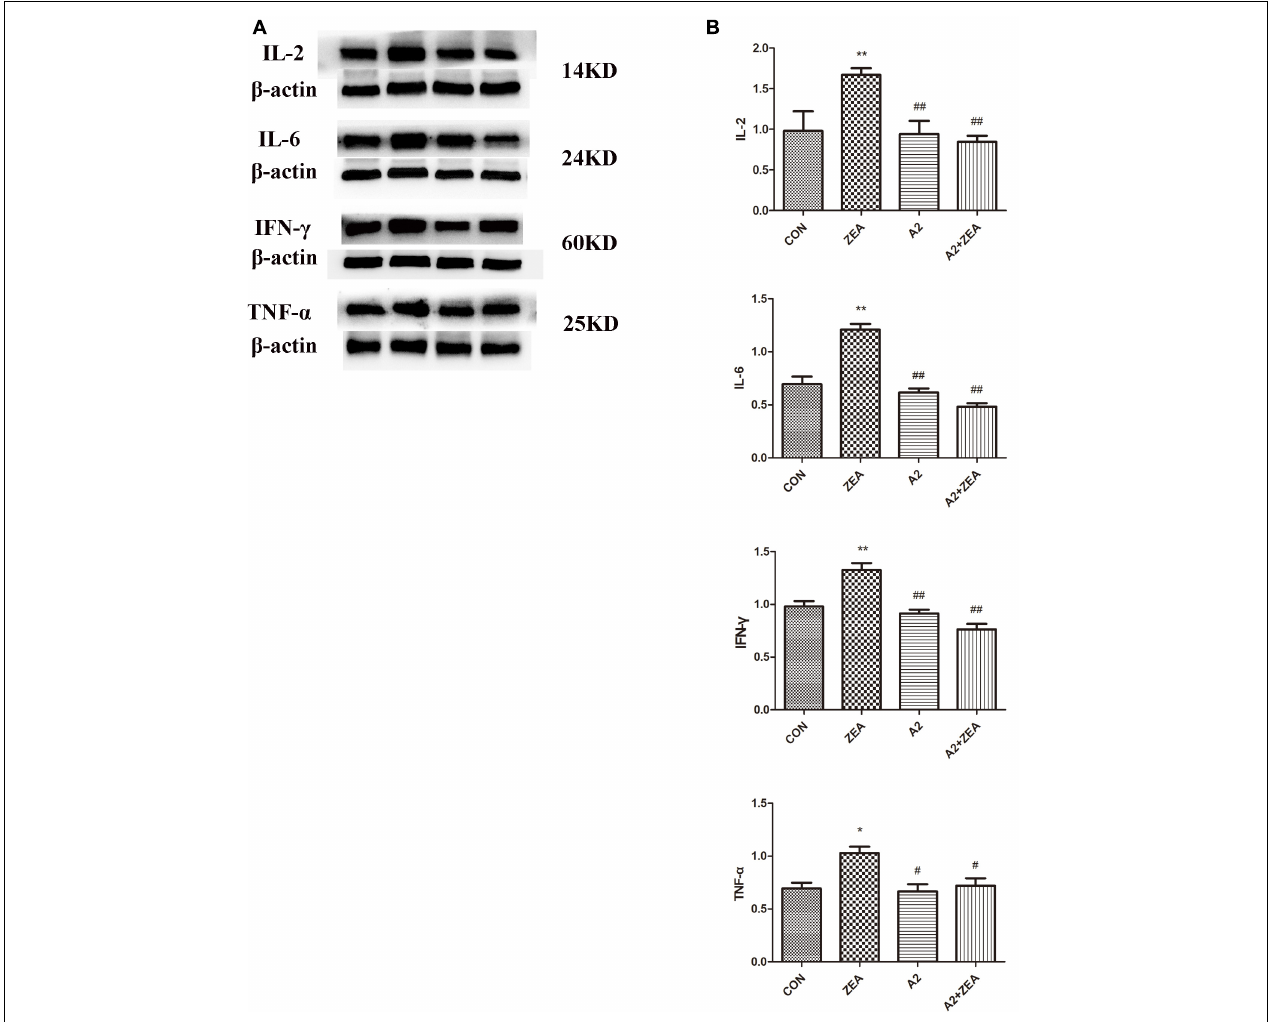
FIGURE 5 | (A) Protein expression of cecal inflammation indicators in each group. (B) The data in the figure were all from at least three independently repeated trials. “*” means a significant difference compared with the CON group ( P < 0.05), and “**” means an extremely significant difference compared with the CON group ( P < 0.01). “#” means a significant difference compared with ZEA ( P < 0.05), “##” means an extremely significant difference compared with ZEA ( P <